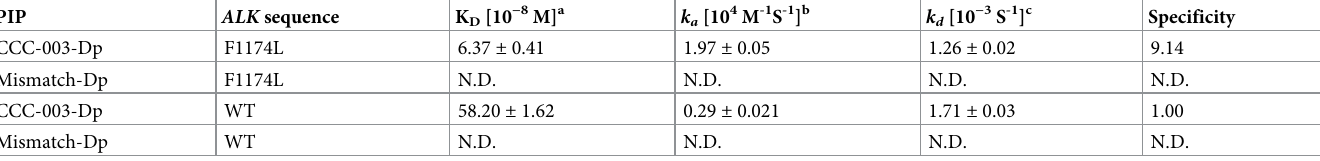
Table 1. Binding affinities of PI polyamides for ALK mutation (F1174L) or ALK wild-type (WT) oligonucleotides. PIP ALK